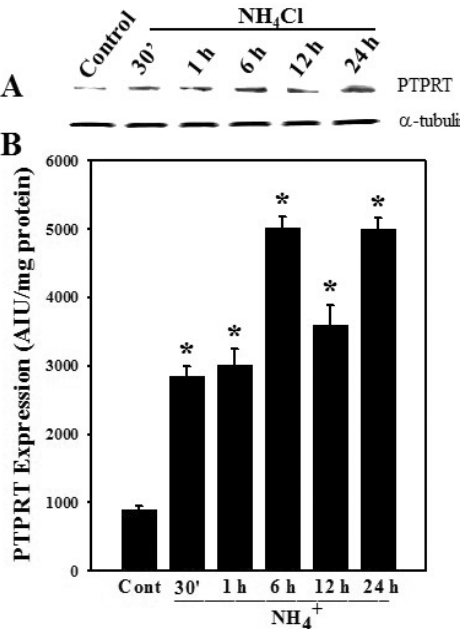
Figure 3. Effect of ammonia on PTPRT expression in cultured astrocytes. ( A ) Immunoblots of PTPRT at different time points (0–24 h) after ammonia treatment (NH 4 Cl; 5 mM). PTPRT expression was increased after ammonia treatment at all time points examined; ( B ) Quantification of PTPRT expression. Data were subjected to ANOVA followed by Tukey‘s post hoc comparison test ( n = 4). * p < 0.05 vs. control. Error bars, mean ± S.E. Cont, control.